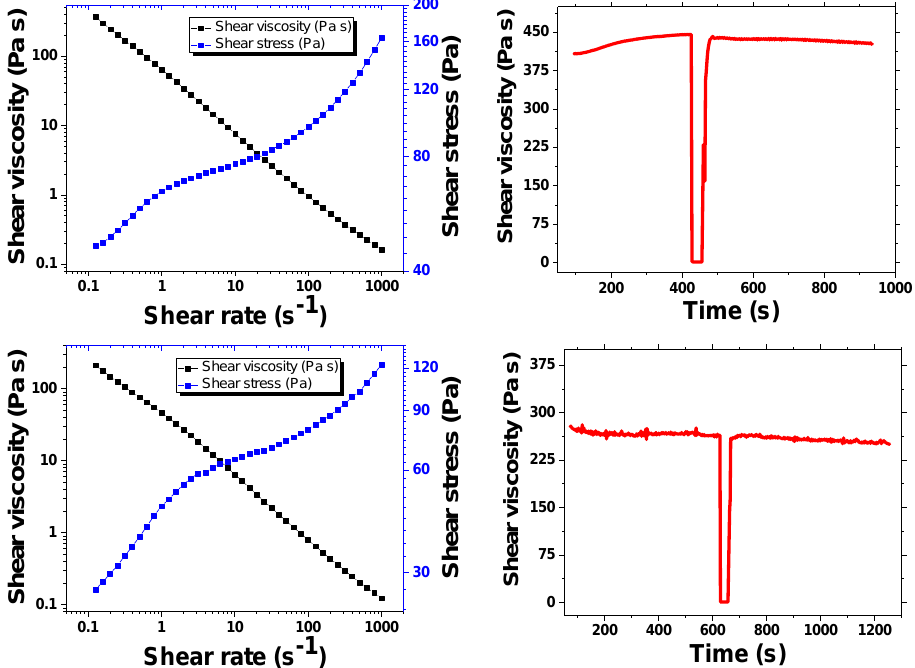
Figure 1. Scheme of the polymer preparation and generator fabrication.